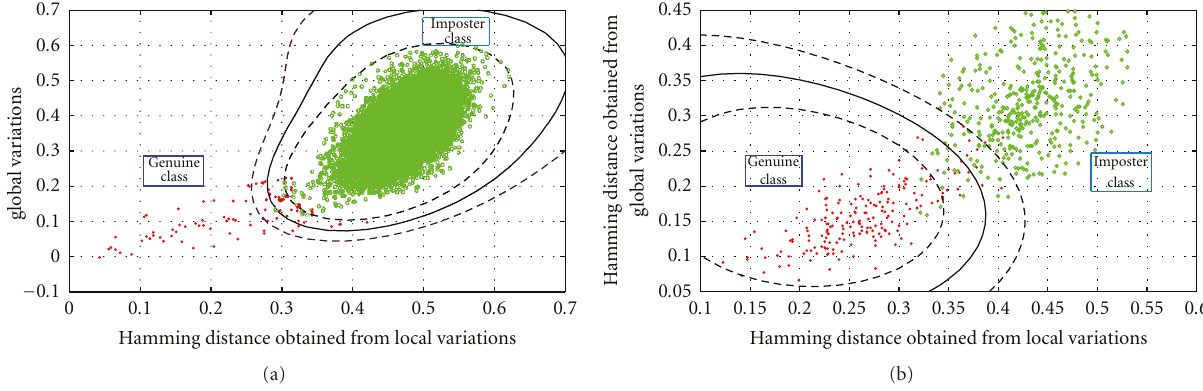
Figure 6: Scatter plot of the genuine and imposter classes along with the discriminating boundary for (a) UBIRIS database, (b) CASIA Version1 database. The black solid curve indicates the SVM boundary, and the black dashed curves delineate the margin boundaries.